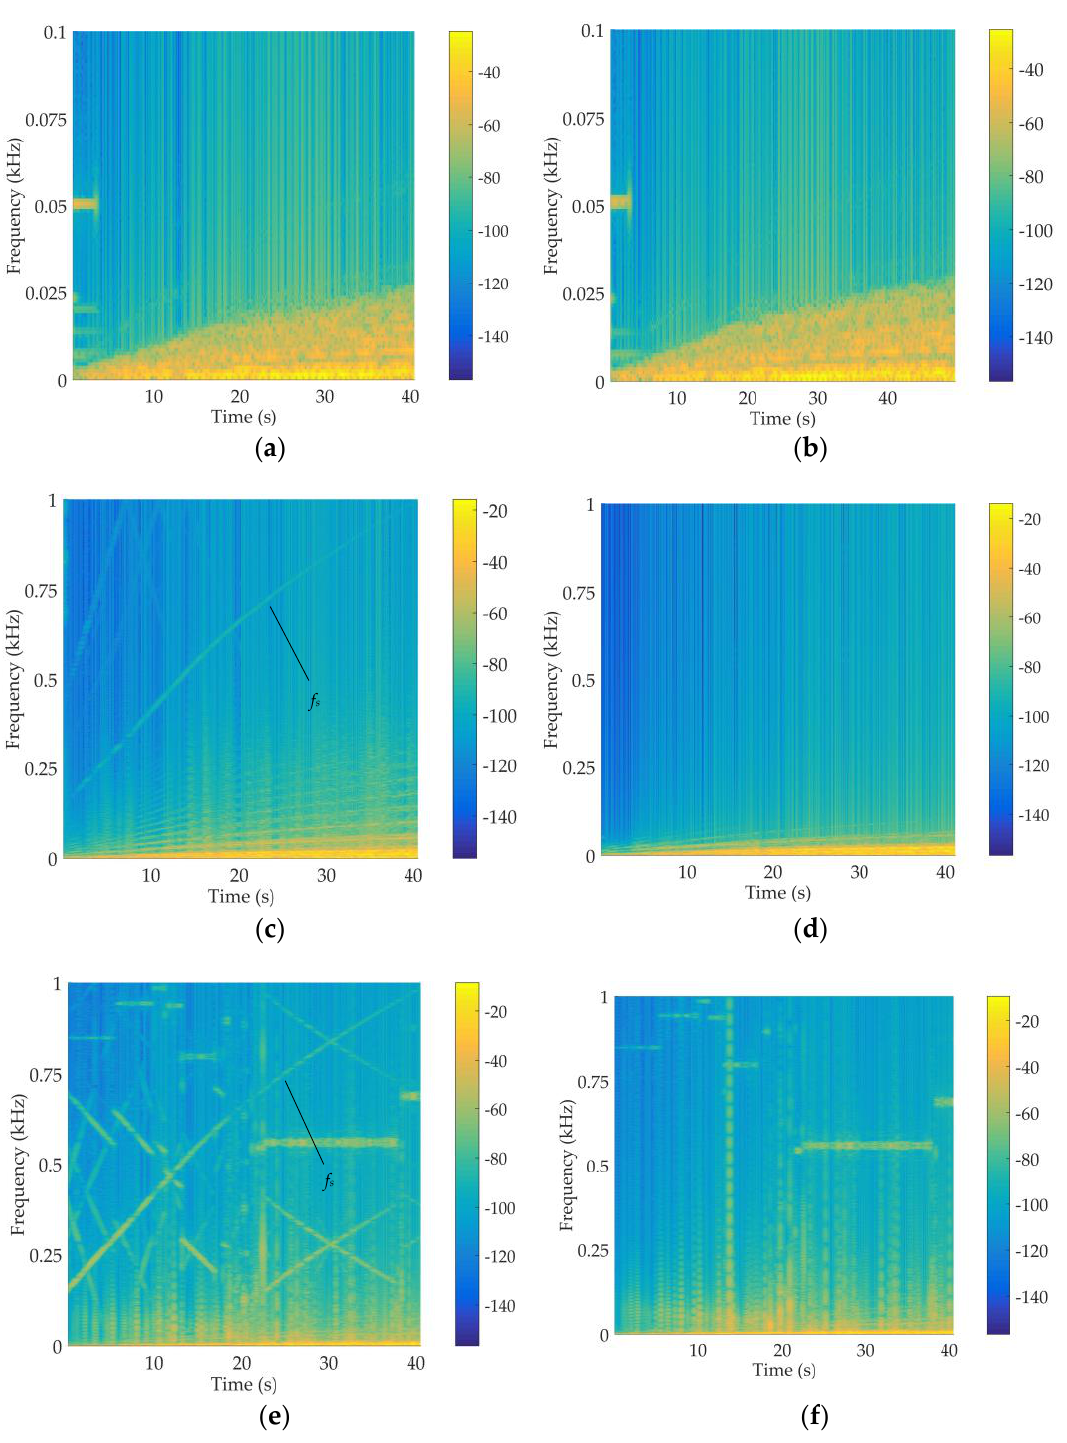
Figure 12. Time – frequency diagram of the lateral vibration acceleration of the motor car and trailer: ( a ) car body of the motor car; ( b ) car body of the trailer; ( c ) bogie frame of the motor car; ( d ) bogie frame of the trailer; ( e ) wheelset of the motor car; and ( f ) wheelset of the trailer.